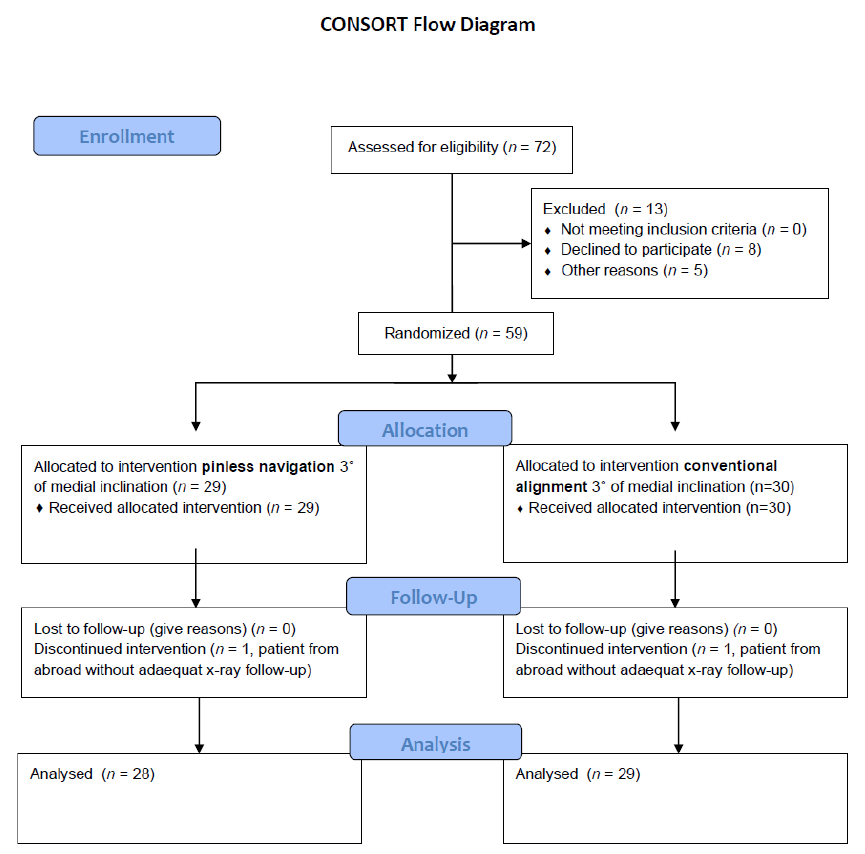
Figure 1. Flow diagram illustrating patient enrolment, allocation, follow-up and analysis. Table 1. Patient characteristics.